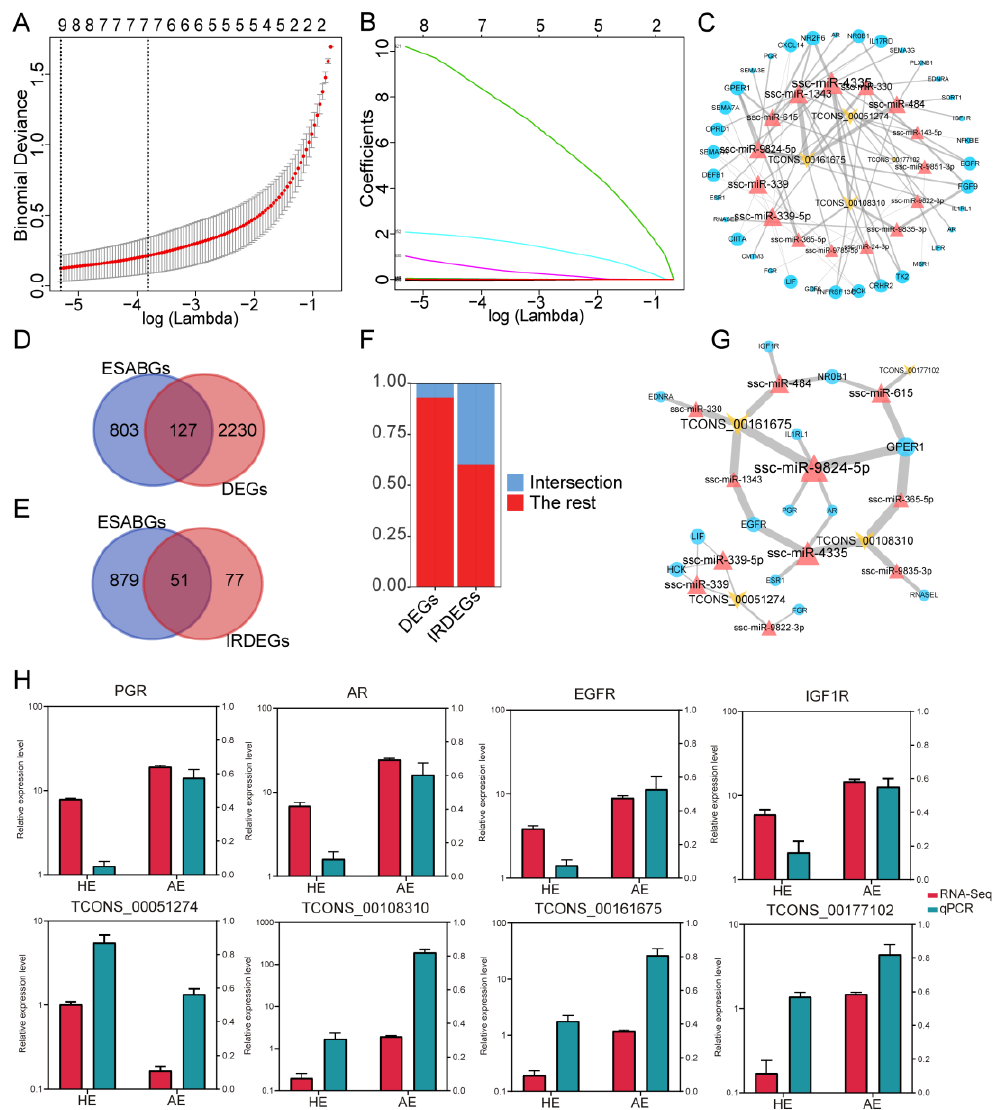
( D ) Venn diagram of immune genes (IGs) and DEGs, the intersection indicates the differentially expressed genes related to immunity. ( E ) PPI network of IRDEGs visualized using Cytoscape. The size of the circle represents the degree of interaction between the genes. Immunohistochemical localization of CD44 in HE ( F ) and AE ( G ). CD44 expression was evident in HE, while almost not expressed in AE. CE: chorionic epithelium; GE: glandular epithelium; LE: luminal epithelium.